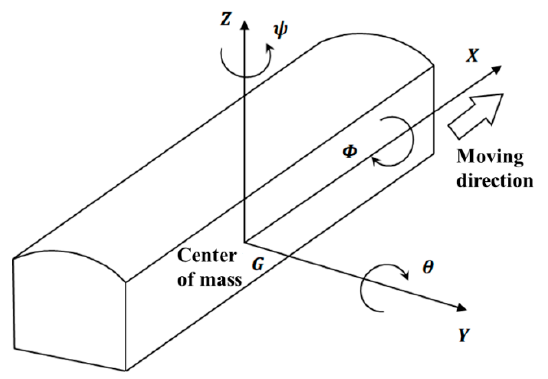
Figure 13. Rigid motion of vehicle.